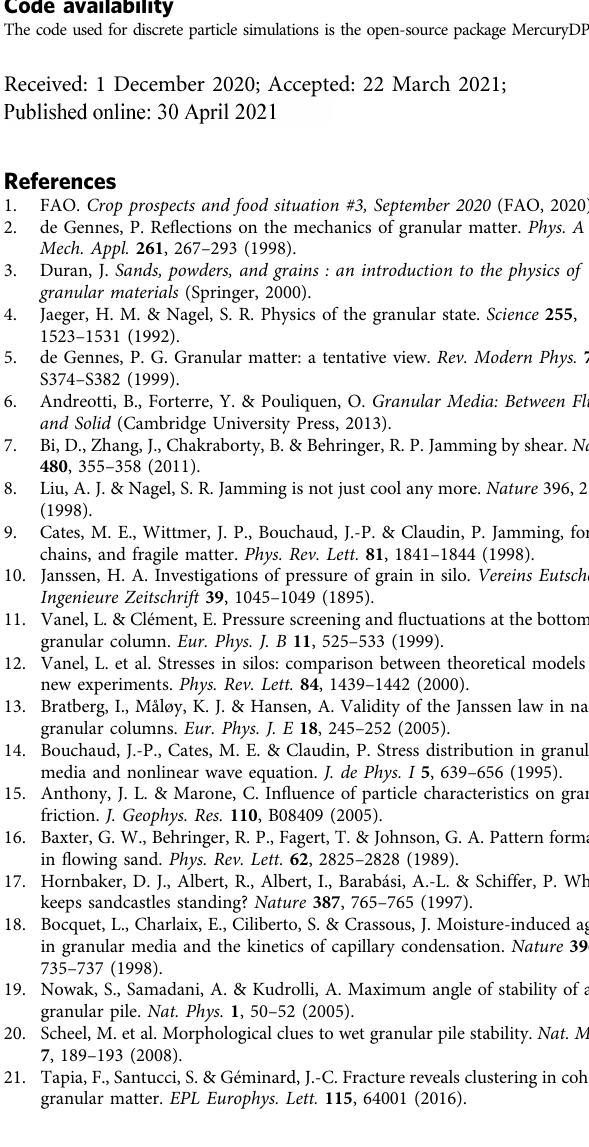
Fig. 4 Invisibility threshold and experimental limitations. a Numerical computation of the critical mass m c zero, as a function of the magnetic fi eld strength, given by the dimensionless number Ψ . This critical mass decreases as a power-law, m c predicted theoretically. The gray zones represent the mass and magnetic fi eld intensity that cannot be reached by our experimental apparatus. b Apparent mass measurement for the highest magnetic fi eld intensity, applied vertically, and comparison to our model